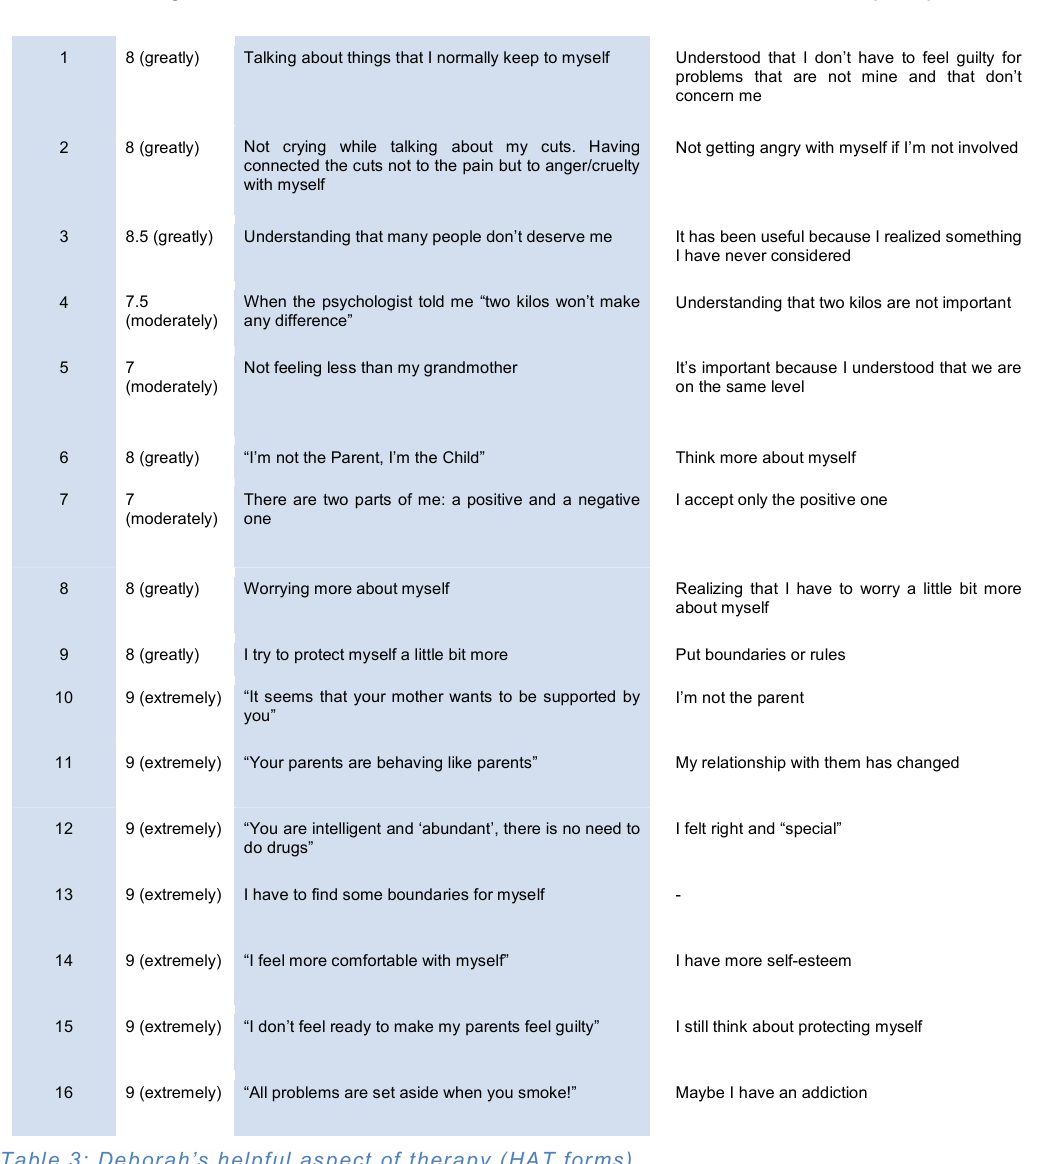
Table 3: Deborah’s helpful aspect of therapy (HAT forms) Note . The rating is on a scale from 1 to 9: 1 = extremely hindering, 5 = neutral, 9 = extremely helpful. HAT = Helpful Aspect of Therapy (Llewelyn,